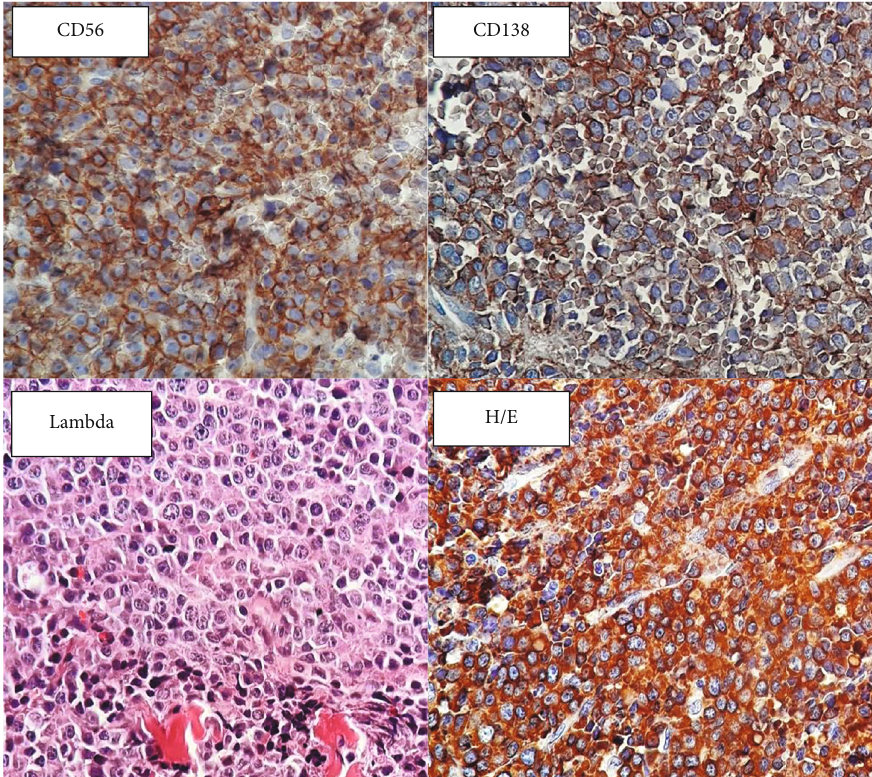
Figure 3: H/E-stained slide show plasmocytoid cells with in fi ltration of muscle fi ber. ( × 400). Tumoral cells di ff use and strongly positive for CD138, CD56, and lambda light